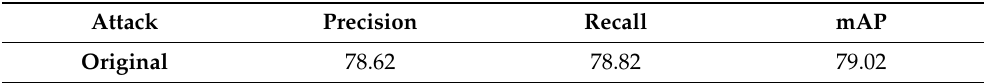
Table 4. Verification data test results when no defence training is applied.